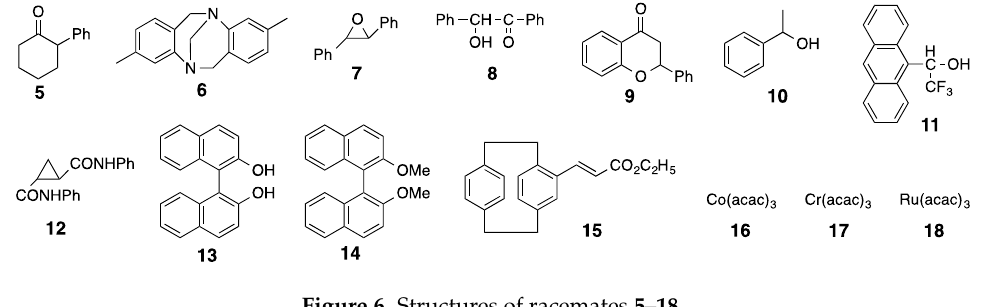
Figure 6. Structures of racemates 5 – 18 . Table 1. Resolution results for racemates 5 – 18 on poly- 2 S , h -poly- 2 S , h -poly-( 2 S 0.36 - co - 3 0.64 ) and h -poly- 4 S a .